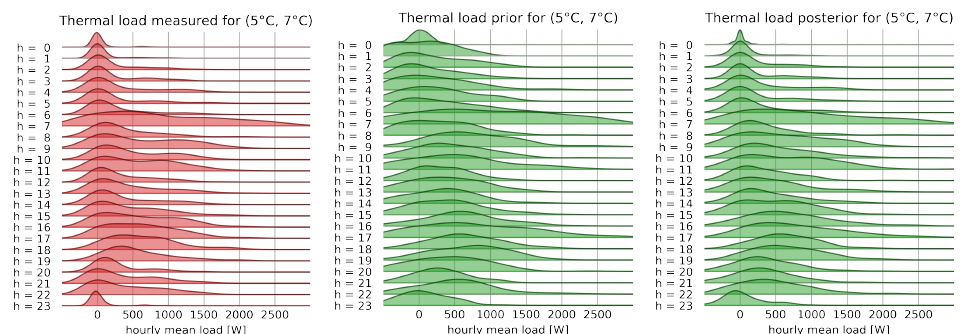
Figure 4. Ridgeline plot of distribution of the measured thermal hourly load, and of its prior and posterior distributions, grouped by the hour of the day, when the average outside temperature is in the range [5–7 °C].